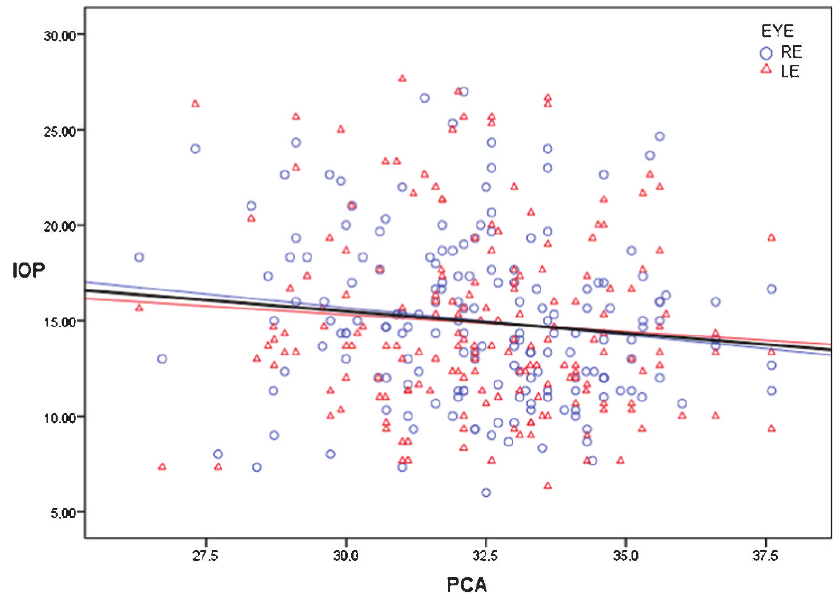
Figure 2 - IOP values and their association with PCA. The lines represent the model that summarizes the association between the IOP and PCA (blue=right eye; red=left